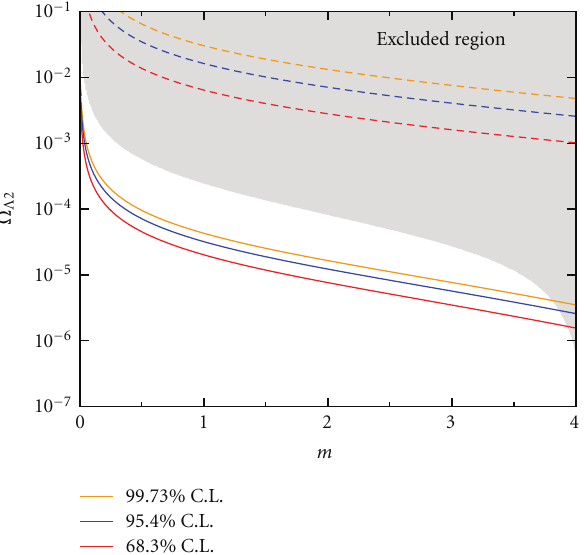
− Ω Λ 2 plane from the recent obser- vations of CMB. The lines indicate upper bounds of 1, 2, and 3 σ confidence level. The dashed and solid lines are the limits deduced from SNIa and CMB temperature observations. The shaded region shows the excluded region obtained from